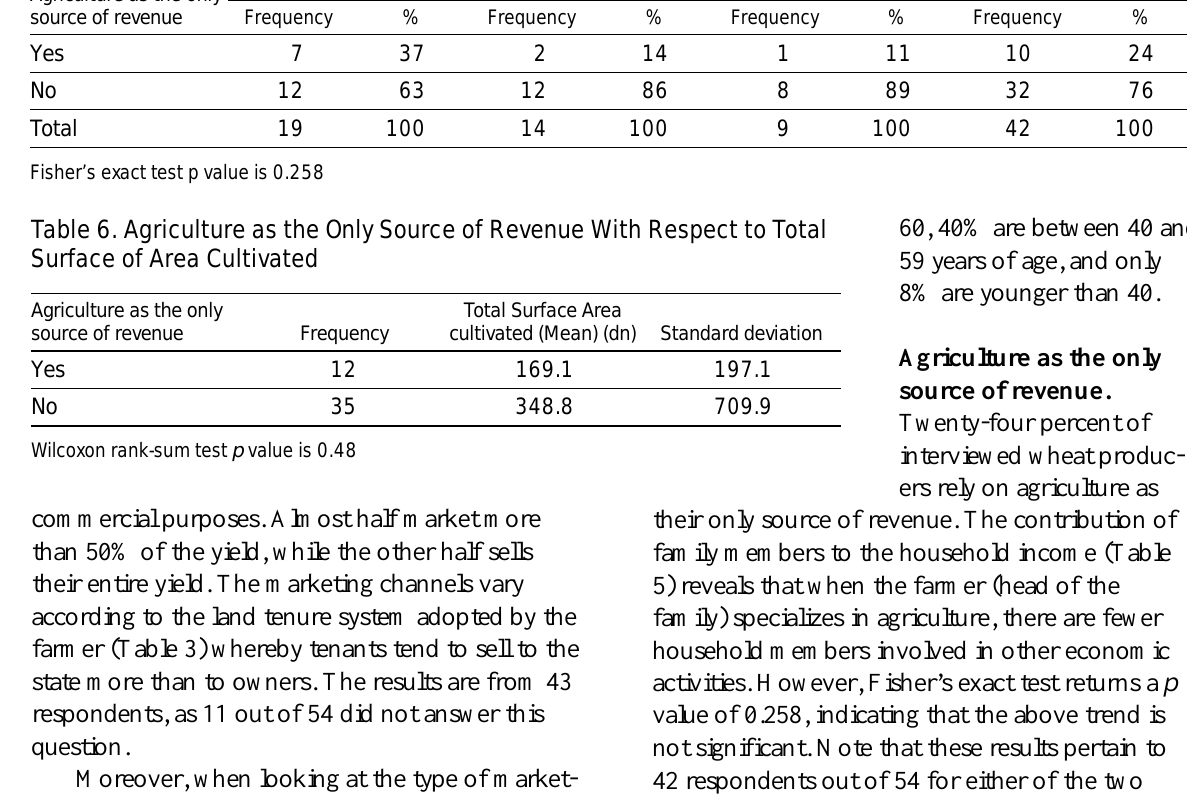
Agriculture as the only source of revenue